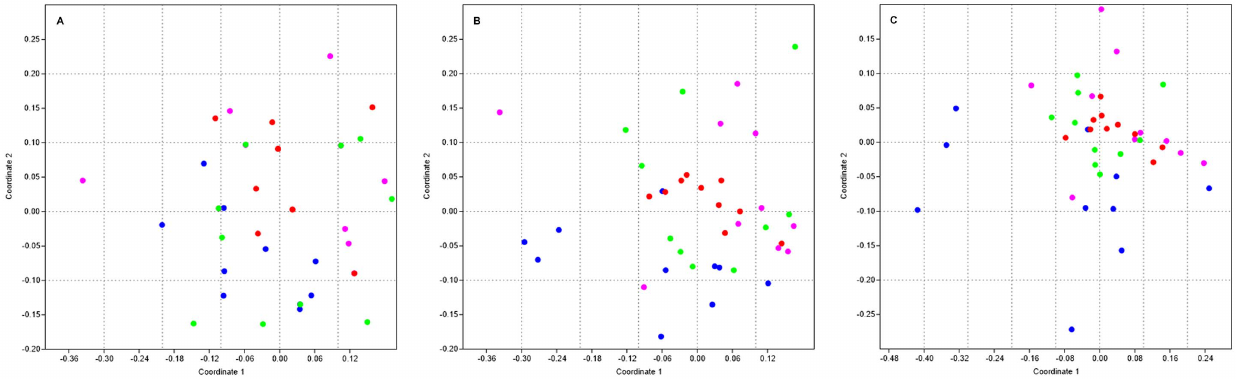
Figure 3. Non-metric multidimensional scaling (NMDS) plots of fungal endophytic communities from the four coffee plantations. NMDS plots based in Jaccard’s index (A), Bray–Curtis coefficient (B), and Euclidean distance (C). Fungal endophytic communities of each coffee plantation are indicated by different colors: blue circles = rustic plantation Huatusco; pink circles = rustic plantation Coatepec; red circles = simple polyculture Huatusco; and green circles = simple polyculture Coatepec.